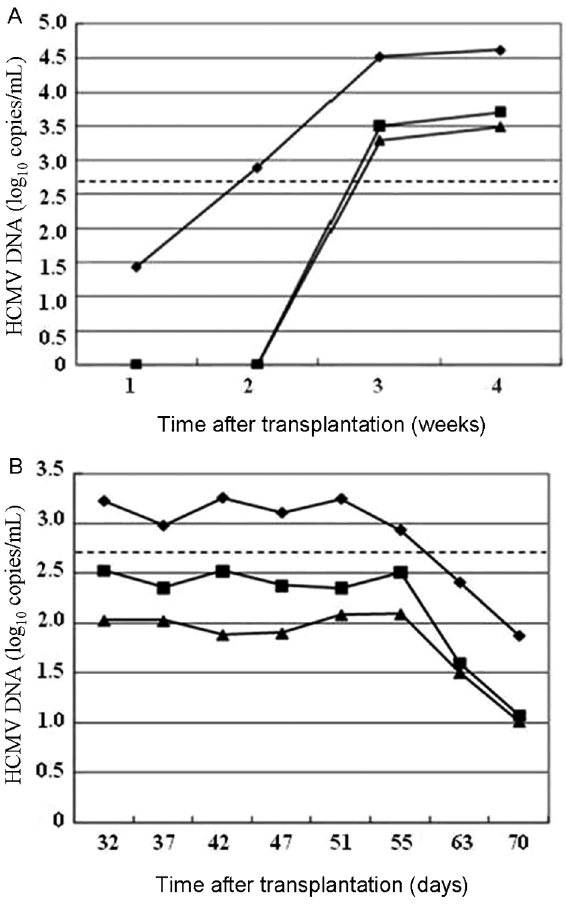
Figure 2. Monitoring of HCMV DNA for 2 clinical cases. A , 1- year-old infant; B , 44-year-old male adult. Lozenges: whole blood; squares: serum; triangles: plasma. The dashed line indicates the limit of detection (2.7 log 10